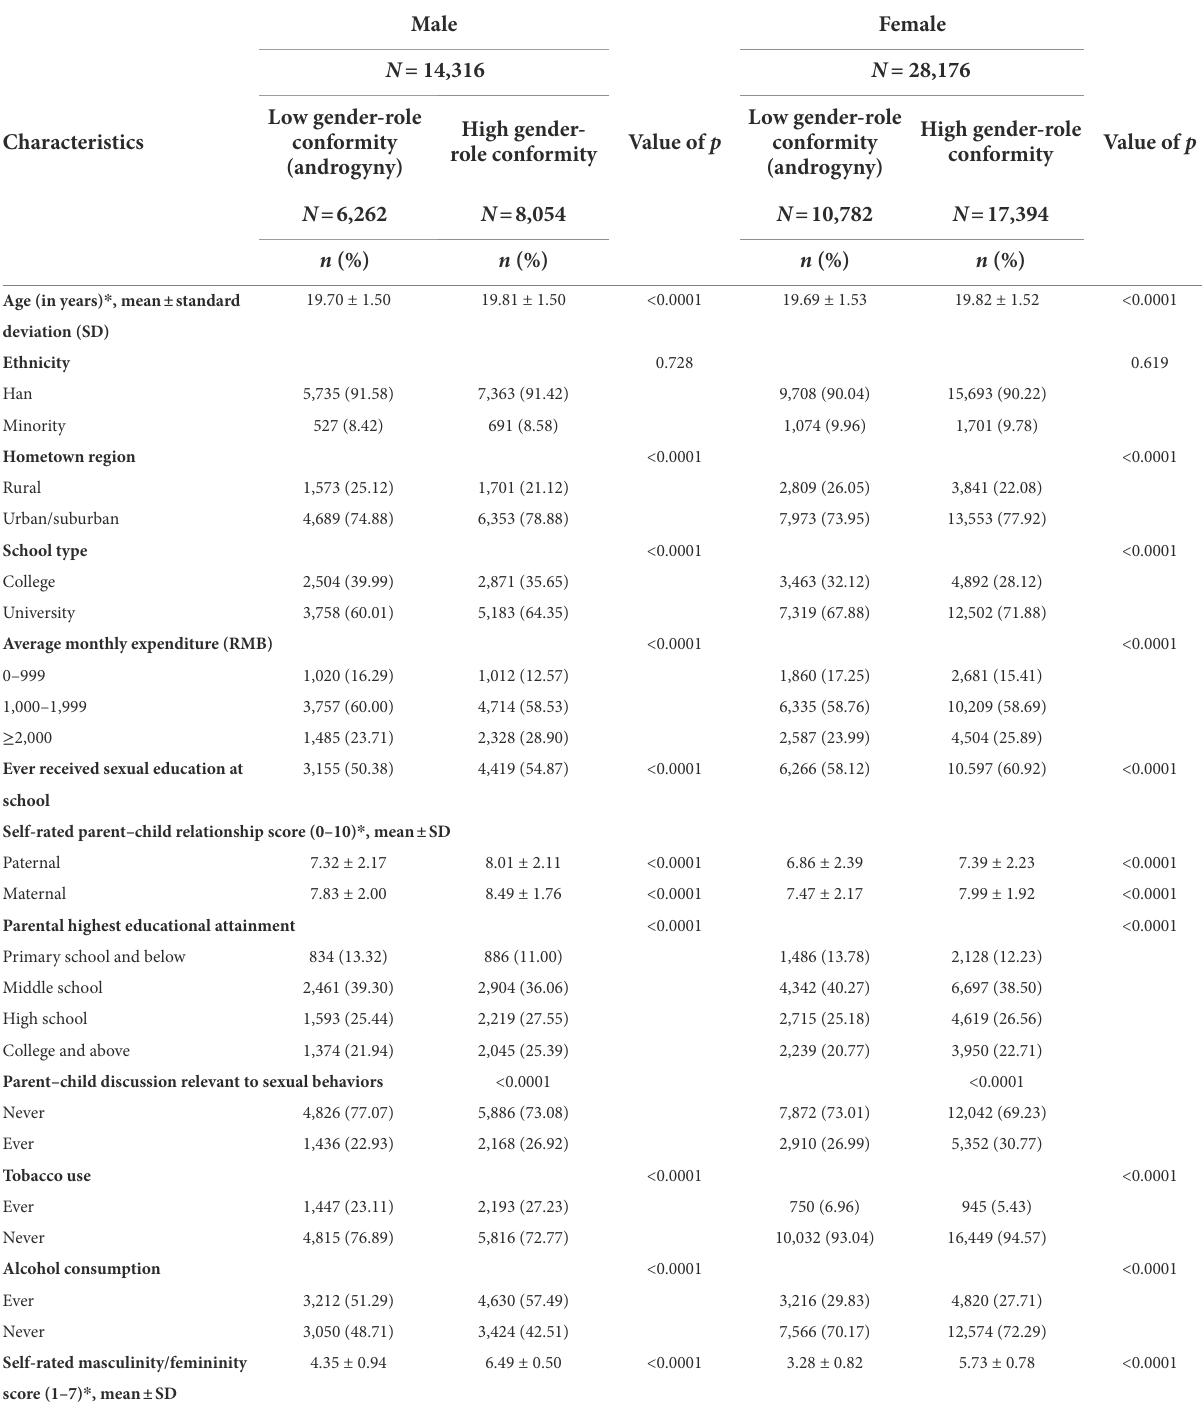
TABLE 1 Sociodemographic characteristics of male and female students stratified by level of gender-role conformity.